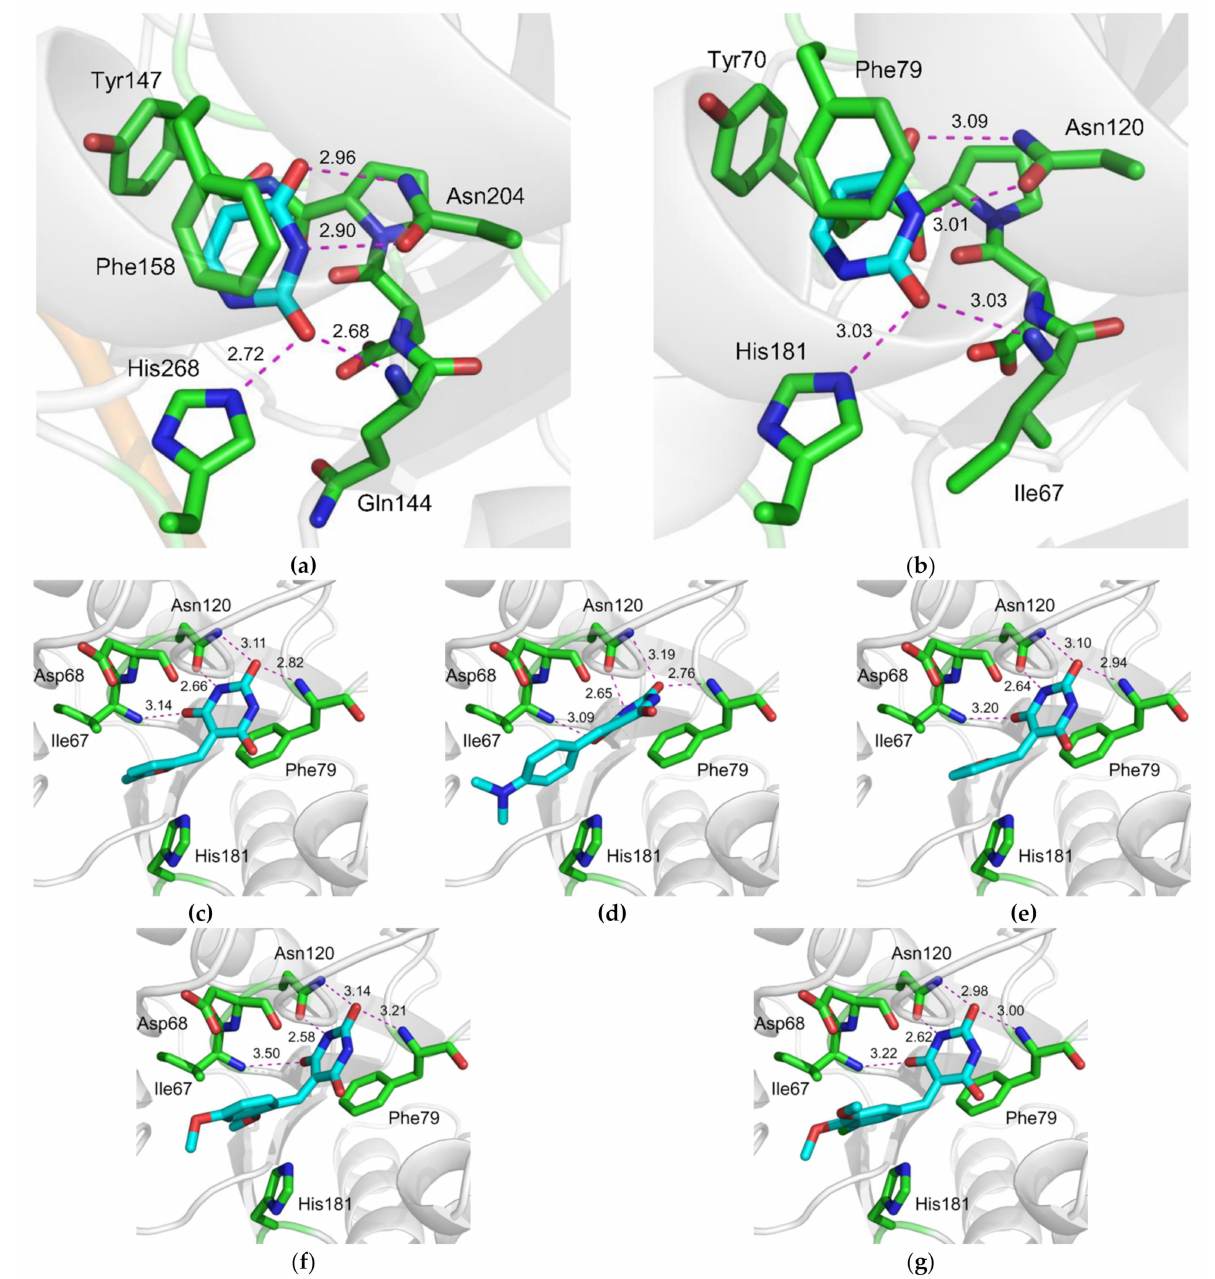
Figure 6. Structures of the uracil-binding pockets of ( a ) hUNG (Protein Data Bank ID 1SSP [44]) and ( b ) vvUNG (4YIG [47]) with the excised Ura base. Both structures also contain the abasic DNA, which is not shown for clarity. ( c – g ) Structure of vvUNG uracil-binding pocket with docked compounds 2D ( c ), 3A ( d ), 3B ( e ), 4B ( f ), and 4F ( g ). Dashes indicate hydrogen bonds; their length in Å is shown. The carbon atoms of the excised uracil base ( a – b ) and the inhibitors ( c – g ) are colored cyan; protein carbons are